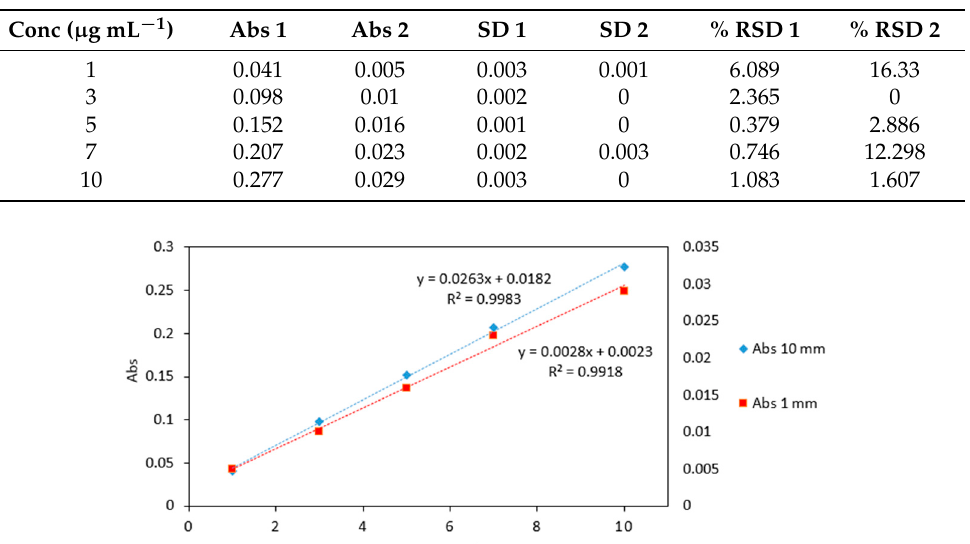
Table 1. Average absorbance values for arsenic samples (0.2–1 µ g mL − 1 ) analyzed in two different types of cuvettes. Abs 1, SD 1 and % RSD 1 show the data for measurements carried out with 10 mm quartz cuvettes. Abs 2, SD 2 and % RSD 2 show the data for measurements in 1 mm quartz cuvettes. All measurements were carried out in triplicate ( n = 30).